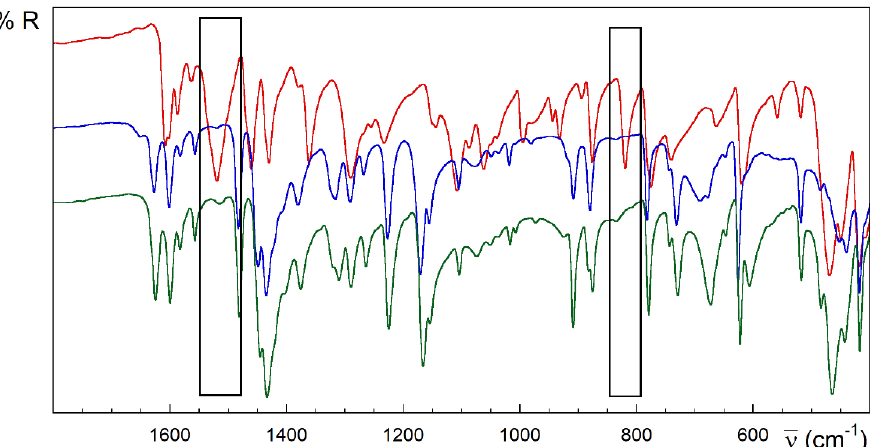
Figure 3. FTIR-ATR spectra of HL (red), 1 (blue) and 2 (green). Rectangles in black highlight the main differences between the spectra of the free ligand and [{CuLX} 2 ] complexes. Figure 4. FTIR-ATR spectra of HL (red) and 3 (blue). Rectangles in black highlight the main differ- ences between the spectra of the free ligand and the complex.